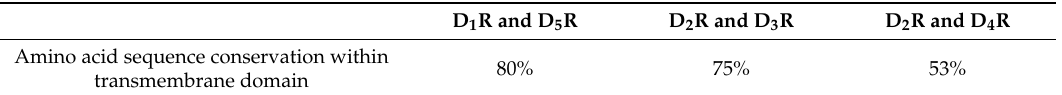
Table 1. Transmembrane segments of D1-like and D2-like dopamine